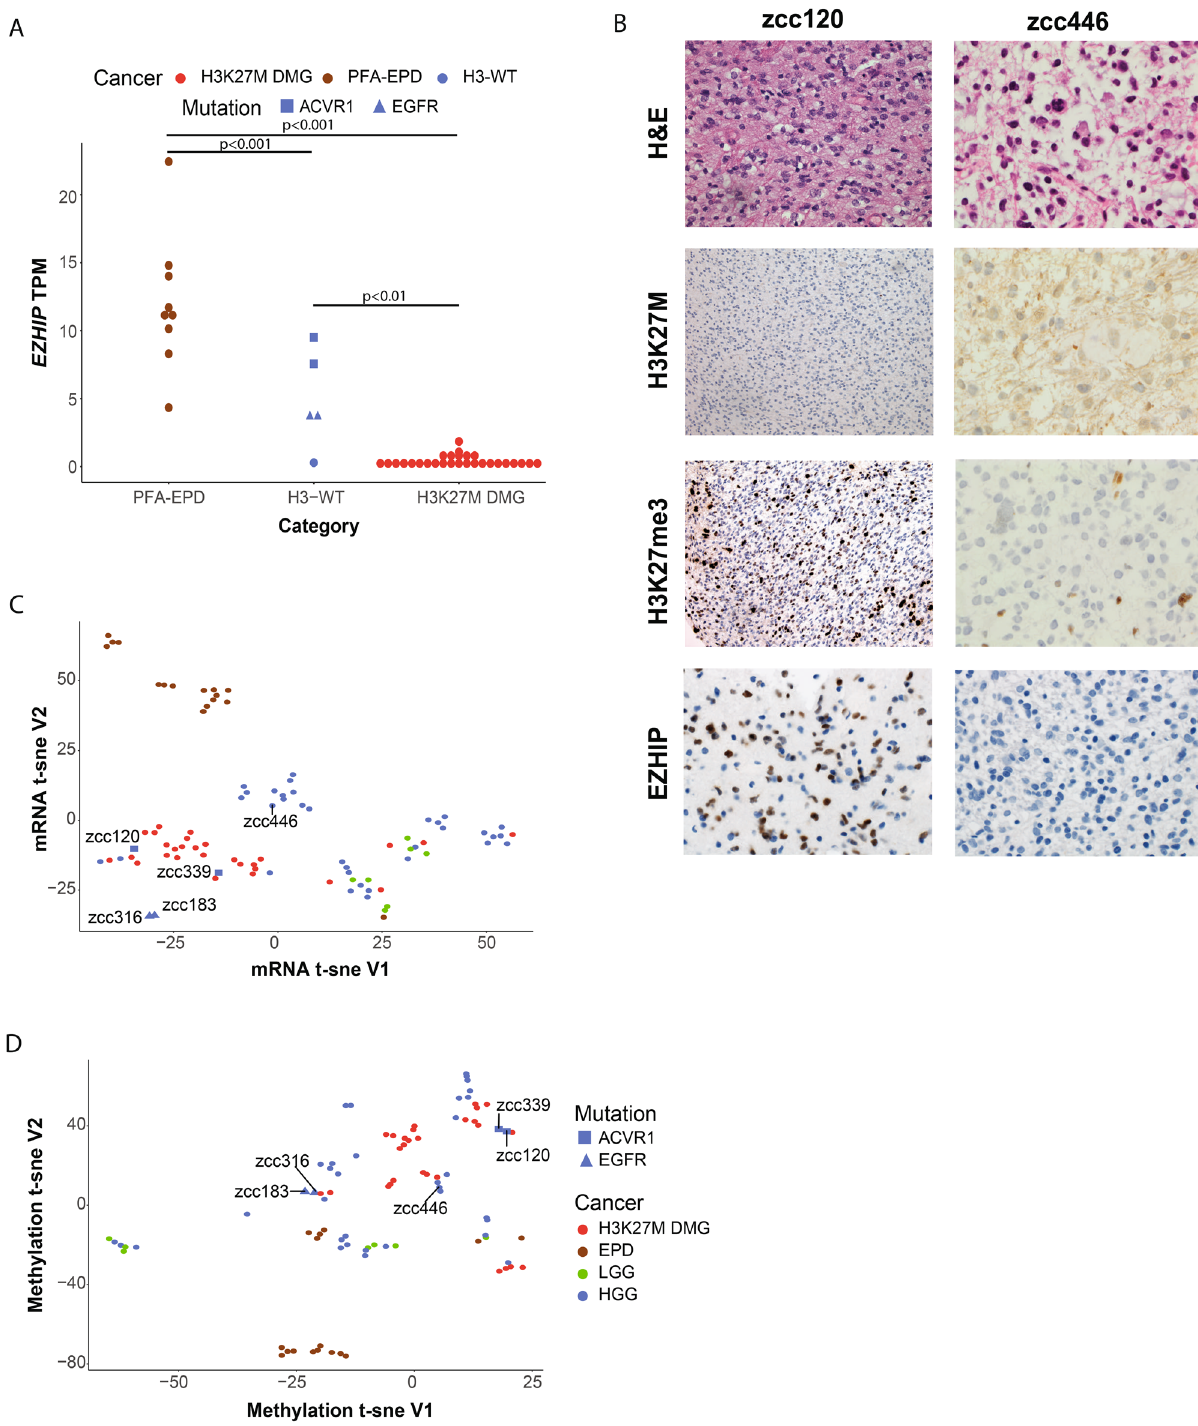
Figure 1. H3-WT patients over-express EZHIP and cluster more closely to diffuse midline gliomas. ( A ) Relative expression of EZHIP (transcript per million (TPM)) in PFA-EPD, H3-WT midline gliomas and H3K27M DMG. ( B ) H&E and immunohistochemistry panel of zcc120 and zcc446 including H&E (400x, 600x, respectively), H3K27M (200x, 600x, respectively), H3K27me3 (200x, 600x, respectively) and EZHIP (400x, 600x, respectively). For zcc120 (left hand panels), immunohistochemical staining demonstrates negative nuclear staining for H3K27M mutant, loss of nuclear staining for H3K27me3 in tumour cells with preserved staining in inflammatory cells, and nuclear expression EZHIP in tumor cells. For zcc446 (right hand panels), immunohistochemical staining demonstrates negative nuclear staining for H3K27M mutant, loss of nuclear staining for H3K27me3 and absent EZHIP nuclear staining. ( C ) t-SNE unsupervised clustering of transcriptome profile and ( D ) methylation profile of all glioma tumours in the ZERO cohort. For a-c patients are highlighted as H3K27M DMG (N = 28; red), PFA-EPD in a and all EPD in b-c (N = 16; brown), LGG (N = 7; green), and HGG (N = 38;